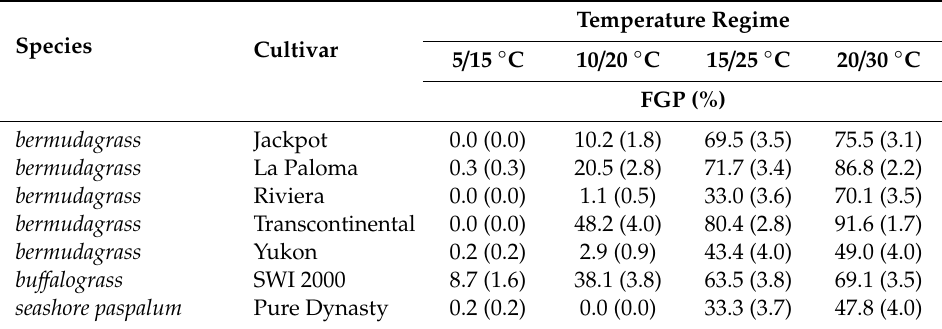
Table 2. Germination percentage (FGP) at the final inspection time of five cultivars of warm-season turfgrass species: bermudagrass ( Cynodon dactylon (L.) Pers. ); bu ff alograss ( Buchloe dactyloides (Nutt.) Englem), and seashore paspalum ( Paspalum vaginatum Swartz.), subjected to four temperature regimes (5 / 15 ◦ C, 10 / 20 ◦ C, 15 / 25 ◦ C, 20 / 30 ◦ C) (The values represent the means of two experiment runs and